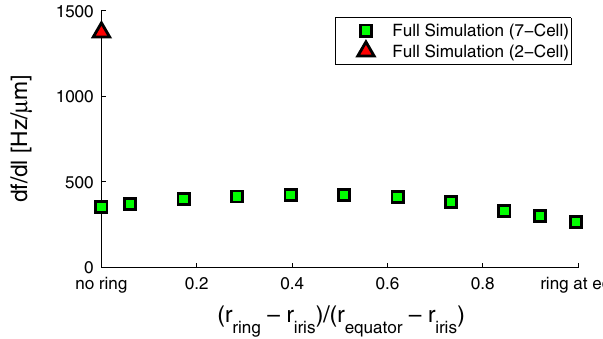
FIG. 8. df=dL of the Cornell ERL 7-cell main linac and 2-cell injector